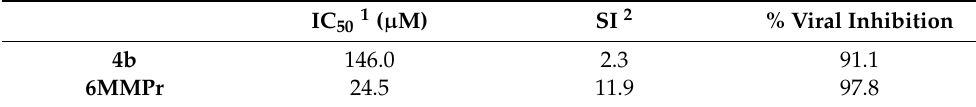
Table 4. Results for post-infection test with 6MMPr and 4b .